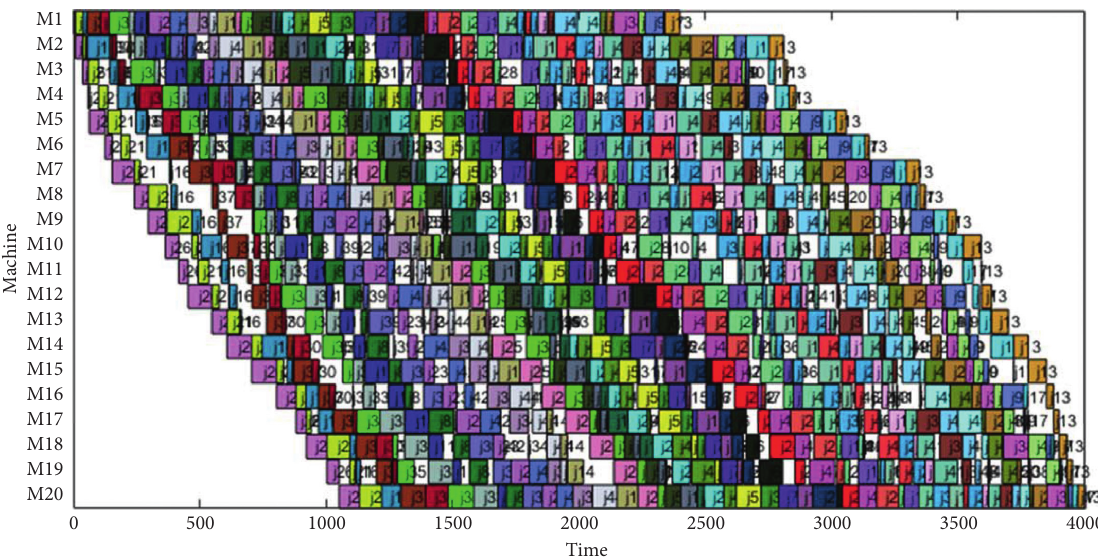
Figure 9: Gantt chart of the solution with SFLA (workpiece: 50, machine: 20, makespan: